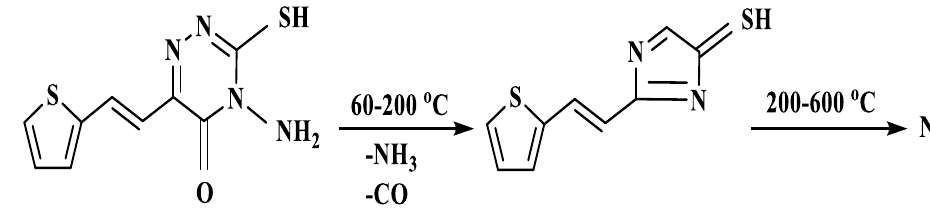
Scheme 2. Suggested thermal decomposition of